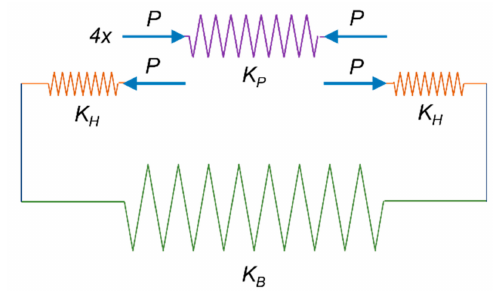
Figure 7. Proposed model for interference estimation.